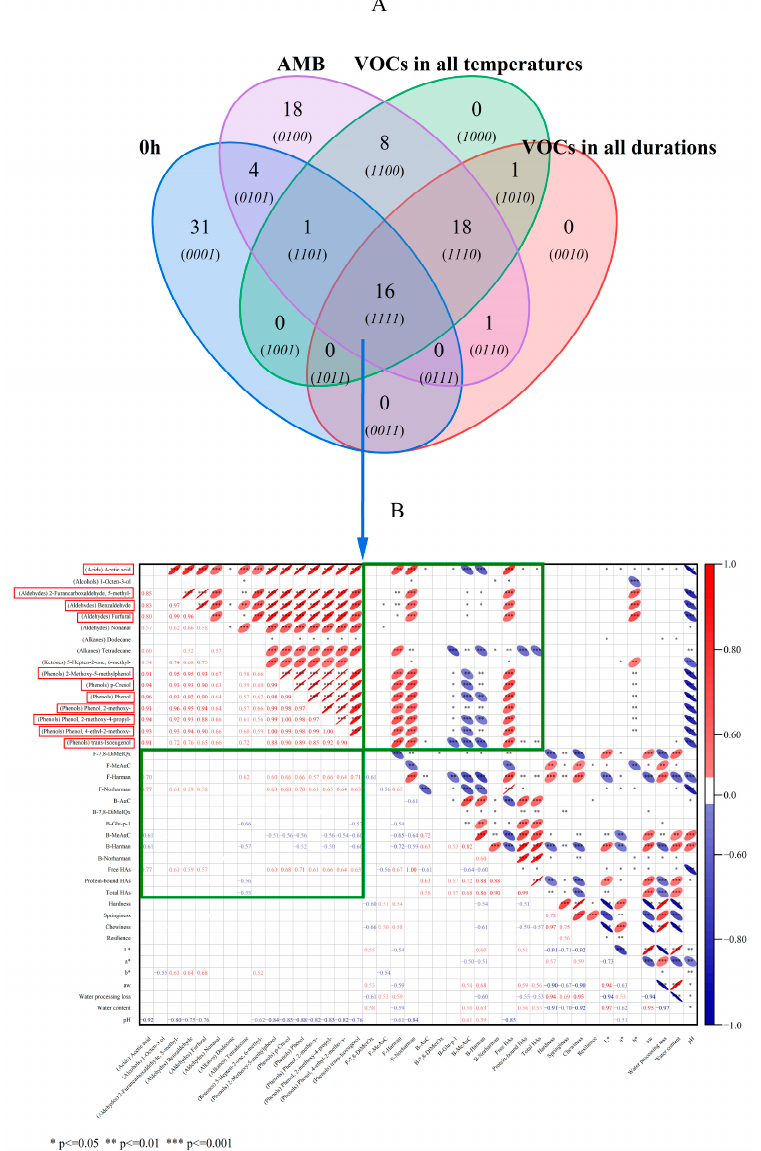
Figure 4. Wayne diagram of VOCs in non-smoked meat patties, at all durations and all temperatures of smoked meat patties ( A ). Correlation analysis of VOCs in all processed meat patties, HAs and other physical and chemical indexes ( B ). AMB represents ambient temperatures.